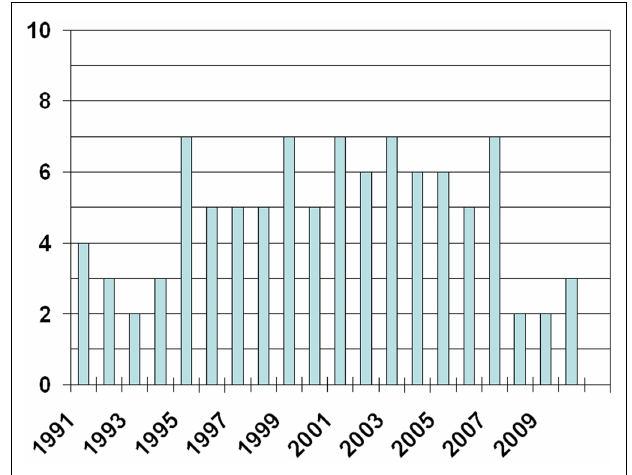
FIGURE 1 | Number of articles published per year